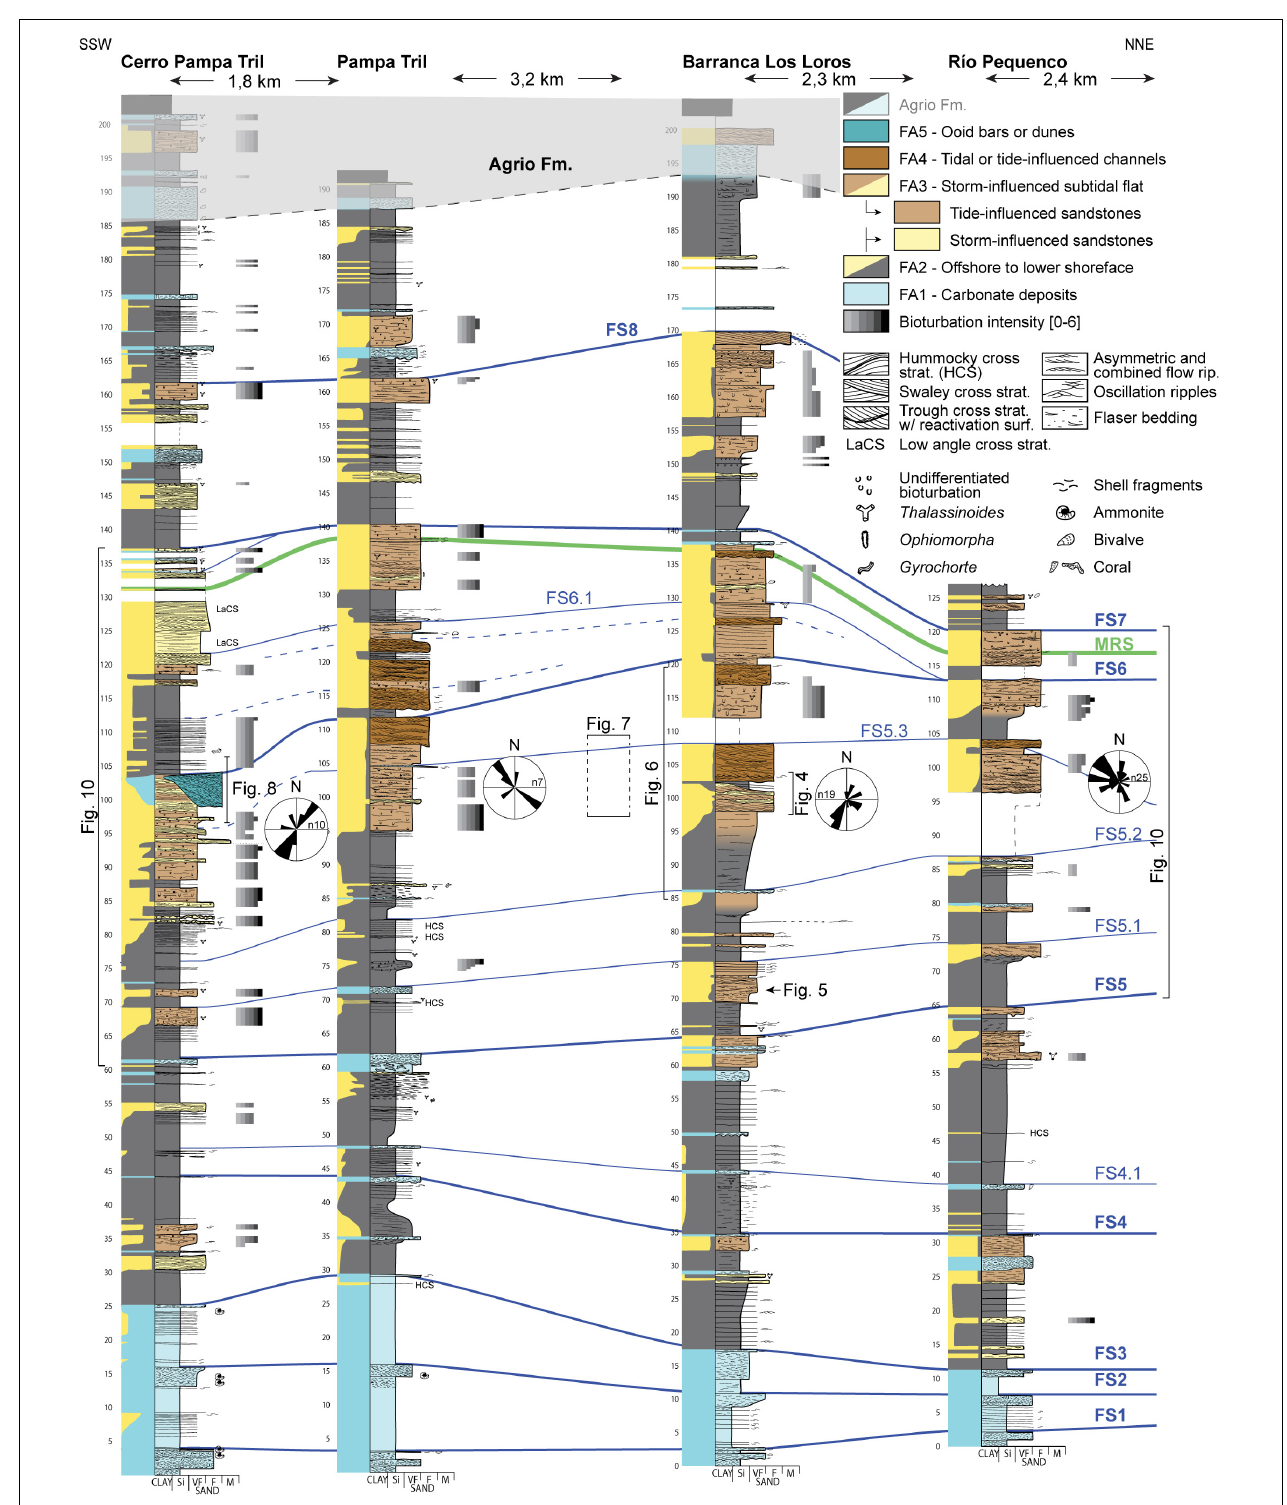
FIGURE 9 | Correlation panel of the recorded succession of middle and upper Mulichinco Fm. deposits; orientation is indicated in top corners. Colors correspond to FAs. FS, flooding surface; MRS, maximum regressive surface. Bold font type corresponds to regional stratigraphic surfaces, decimal numbers correspond to subordinate and local flooding surfaces, and blue dotted lines refer to subordinate flooding surfaces (interpreted from facies correlation and not from virtual outcrop models); relative content of sand (yellow), mud (gray), and carbonate (blue) is indicated by lithologic columns to the left of each log trace. See legend for representative structures and symbols. Annotations of stratigraphic location of figures included; paleocurrent rose plots for focus interval of FA3 included.